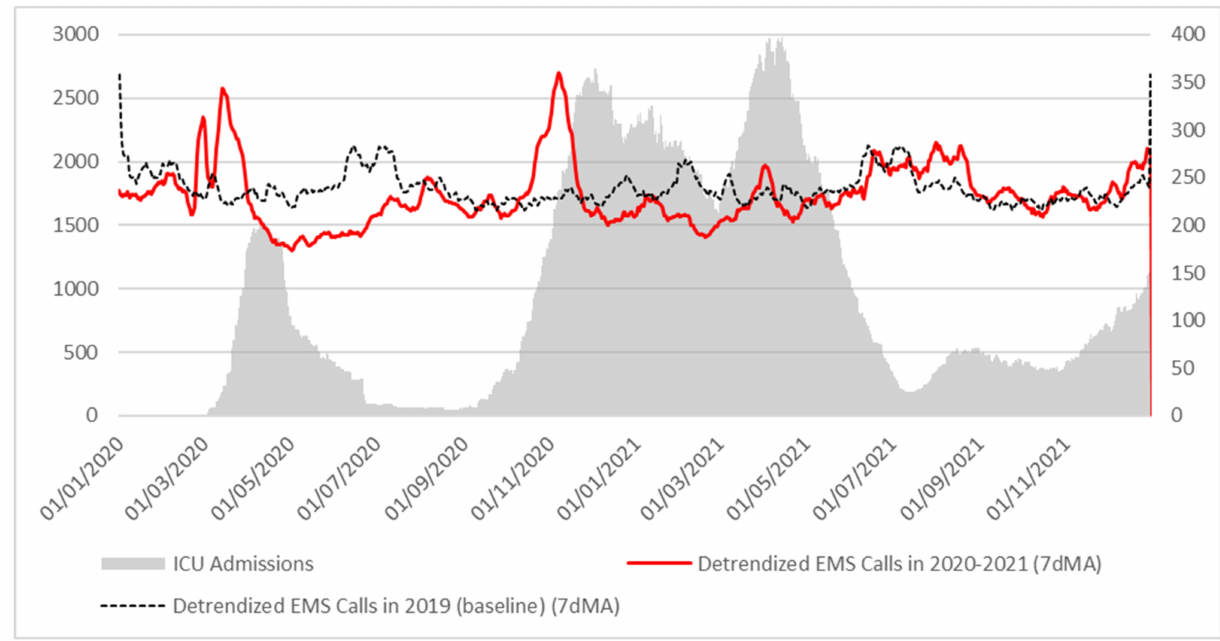
Figure 3. EMS calls and ICU admissions in Lazio region, Italy,